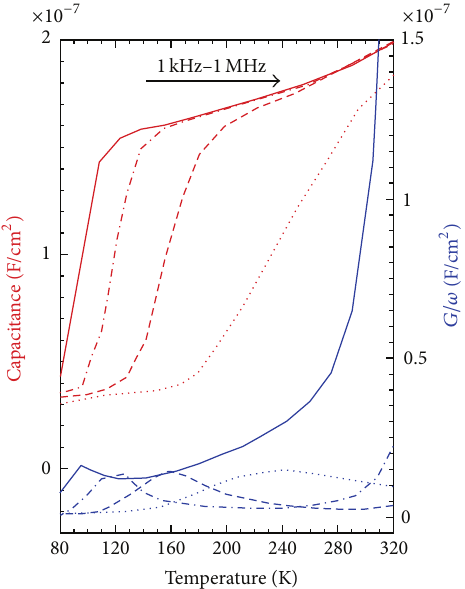
𝜔 and G / 𝜔 - T - 𝜔 curves for GaInP/Ge subcell het- erostructures